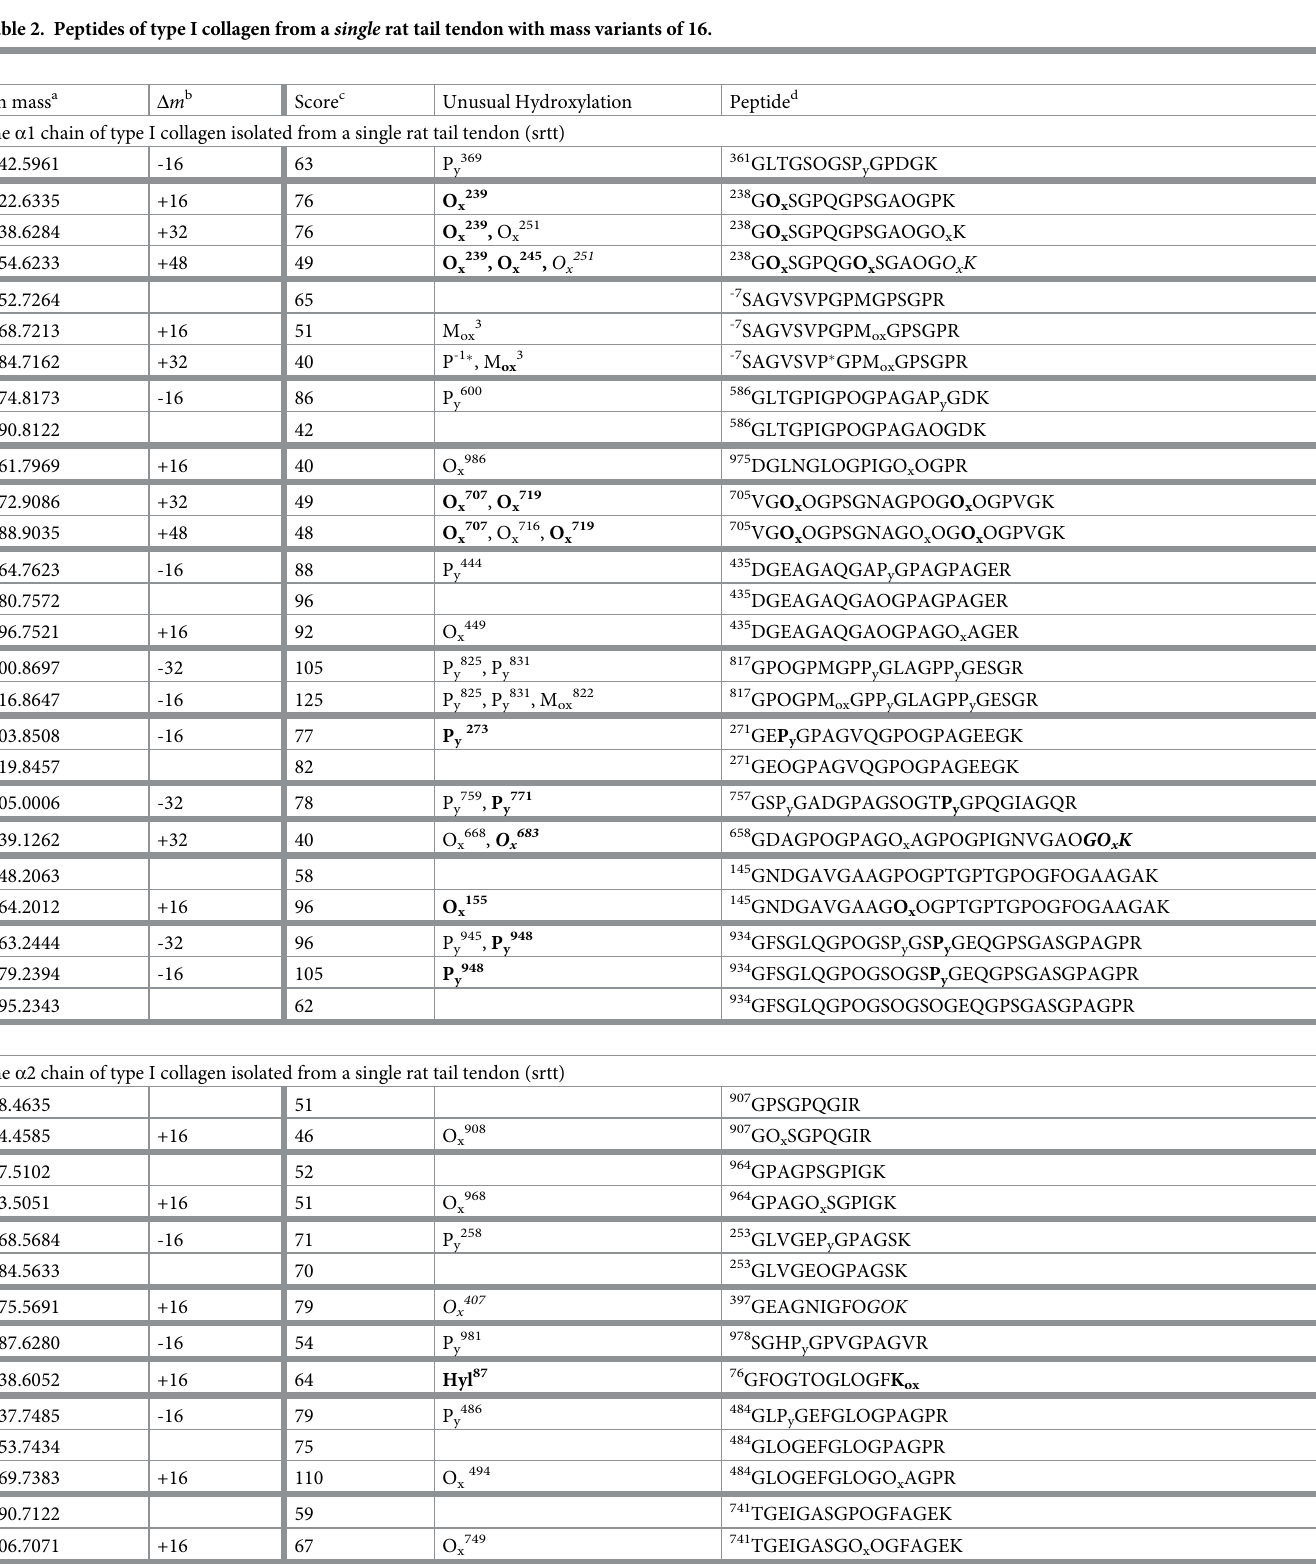
Table 2. Peptides of type I collagen from a single rat tail tendon with mass variants of 16. A Ion mass a Δ m b Score c Unusual Hydroxylation Peptide d The α 1 chain of type I collagen isolated from a single rat tail tendon (srtt) 1242.5961